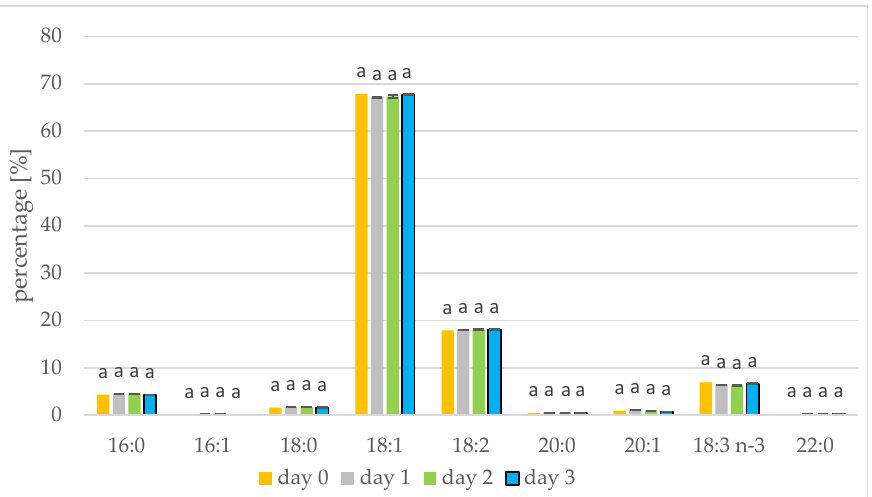
Figure 1. Fatty acid composition [%] of rapeseed oil on days 1, 2, and 3 of germination. 16:0—palmitic acid; 16:1—palmitoleic acid; 18:0—stearic acid; 18:1—oleic acid; 18:2—linoleic acid; 20:0—arachidic acid; 20:1—eicosenoic acid; 18:3 n-3—linolenic acid; 22:0—behenic acid (values are means ± SD from three experiments. Values with different letters are significantly different ( p < 0.05)).